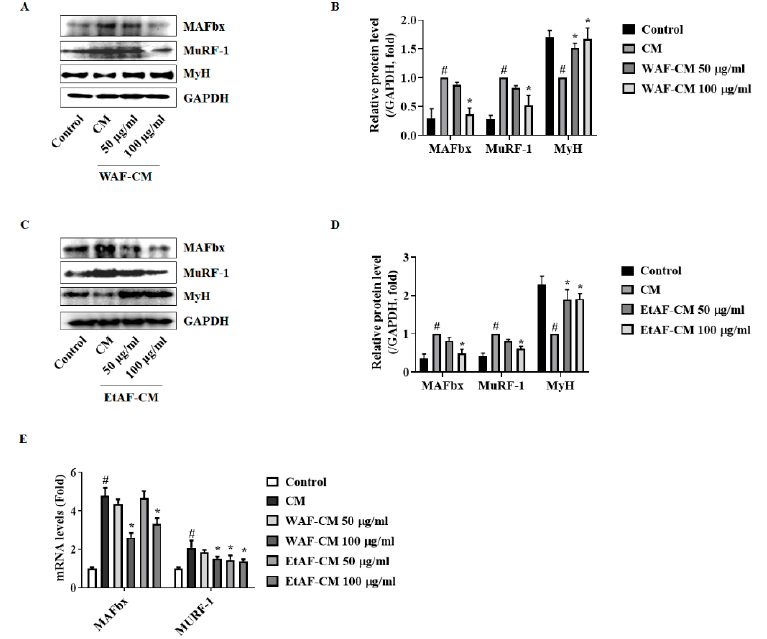
Figure 8. Effects of AF on C2C12 myoblast treated with conditioned media (CM) from CT-26 cells. Protein levels of MAFbx, MuRF-1, and MyH were measured after treating WAF-CM ( A ). The relative protein expression levels of MAFbx, MuRF-1, and MyH ( B ). Protein levels of MAFbx, MuRF-1, and MyH were measured after treating with EtAF-CM ( C ). The relative protein expression levels ( D ). GAPDH was endogenous control. mRNA levels of MAFbx and MuRF-1 were measured ( E ). GAPDH was used as an endogenous control. The results are from three independent experiments. All values are mean ± SD. # p < 0.05, significantly different from control group; * p < 0.05, significantly different from CM group.